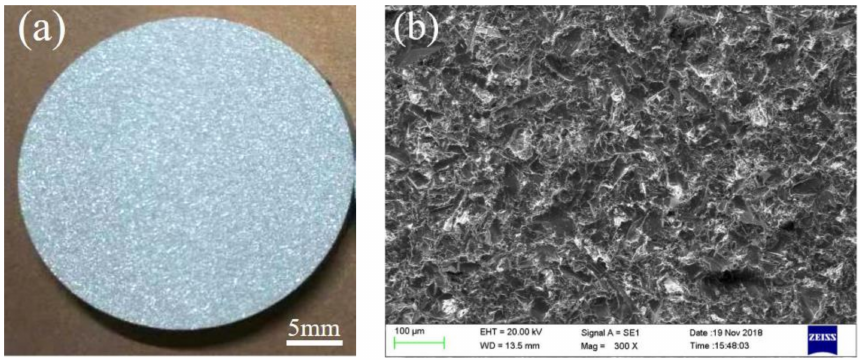
Figure 1. Surface topography of a R683/IC45e carbon steel substrate after blasting: ( a ) macro; ( b ) micro.